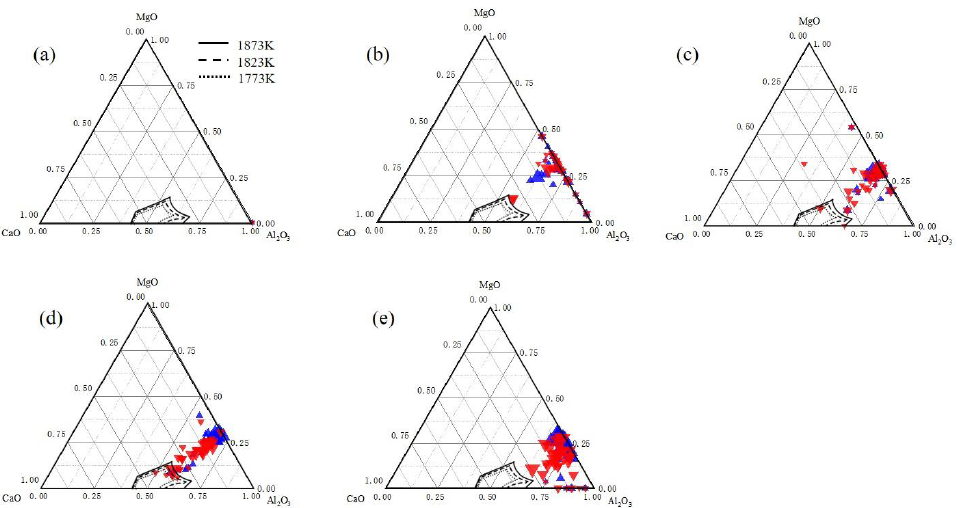
Figure 9. Composition of inclusions when adding Mg together with Ca ( a ) 30 s after Al addition, ( b ) 30 s after Mg–Ca addition, ( c ) 5 min after Mg–Ca addition, ( d ) 15 min after Mg–Ca addition, ( e ) 30 min after Mg–Ca addition.